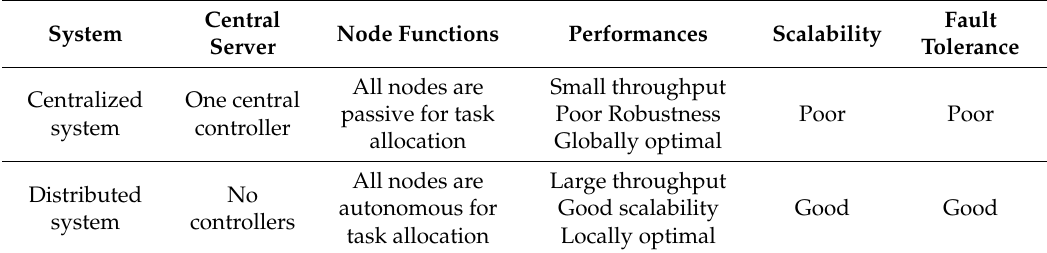
Figure 2. ( a ) Centralized face recognition; ( b ) distributed face recognition; ( c ) server-agent interaction in the distributed face recognition. Table 1. The comparisons of two